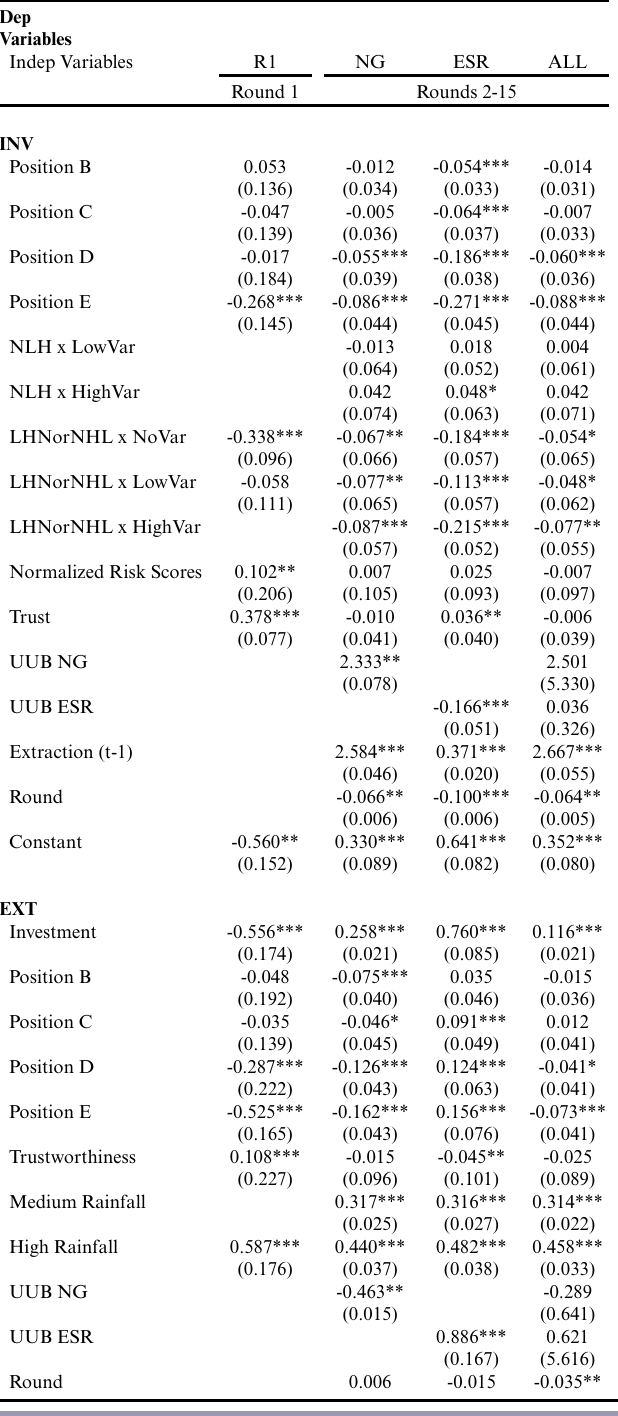
Table 6 . Results for the model reported in equation 5 with standardized